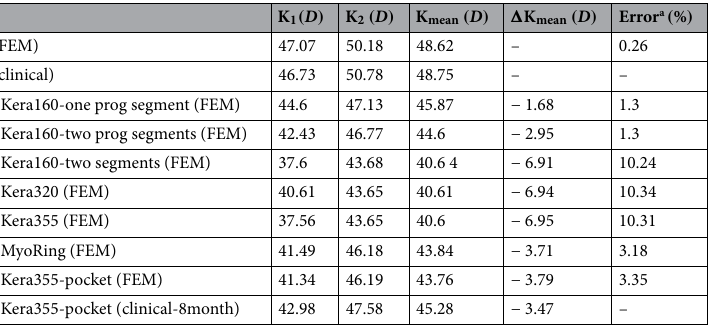
Table 3. Pre- and postoperative keratometry results of the third case. a Percentage error of FEM predictaed K mean .